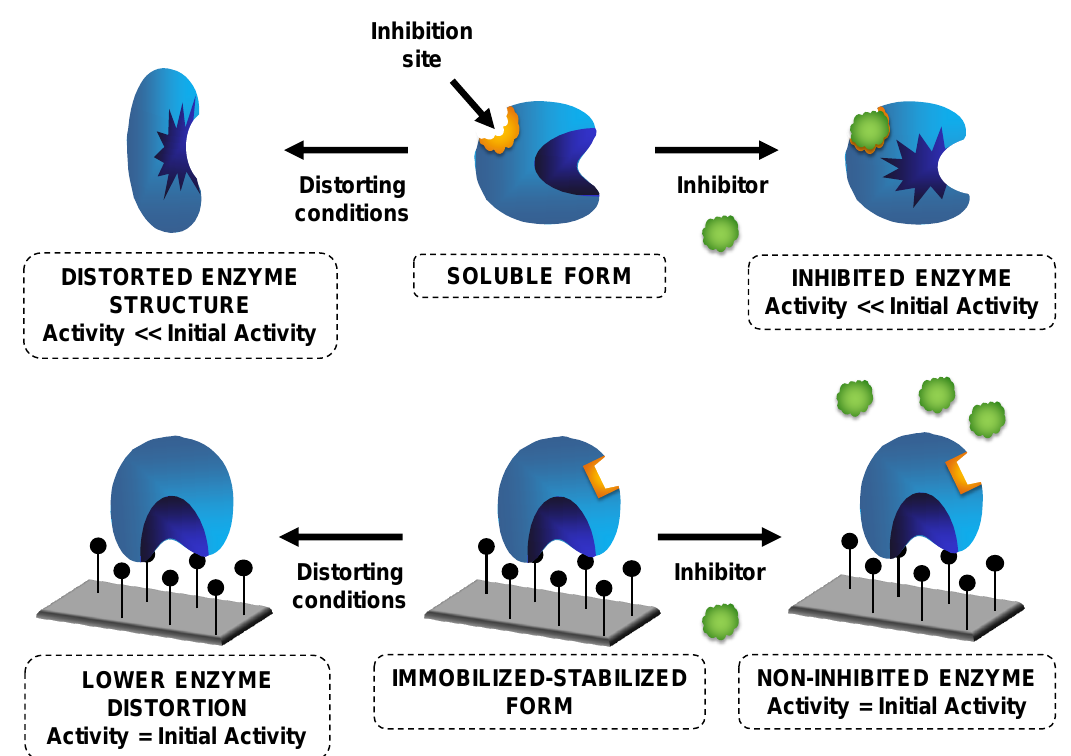
Figure 16. Effect of the stabilization of the enzyme after immobilization on enzyme activity in the presence of inhibitors or distorting conditions.